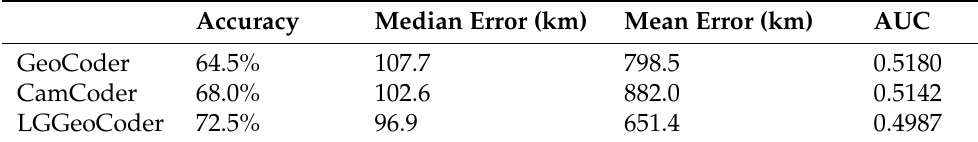
Table 1. The prediction performance compared with the baseline models